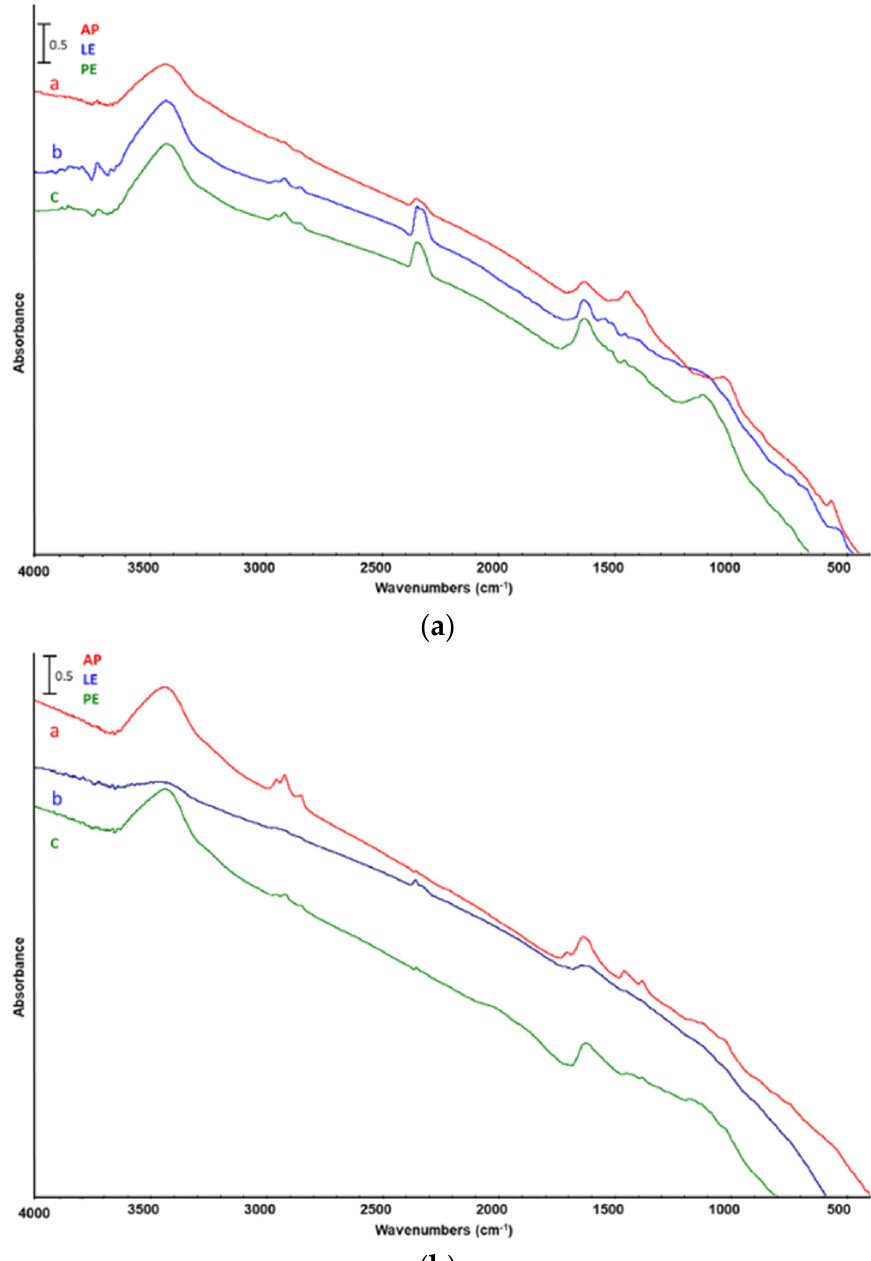
Figure 9. FTIR analysis of solid residue from catalytic pyrolysis of a— Arthrospira platensis untreated biomass (AP), b—biomass after lipid extraction (LE), and c—biomass after protein extraction (PE). Catalyst: ( a ) ZSM5, ( b ) silica–alumina.